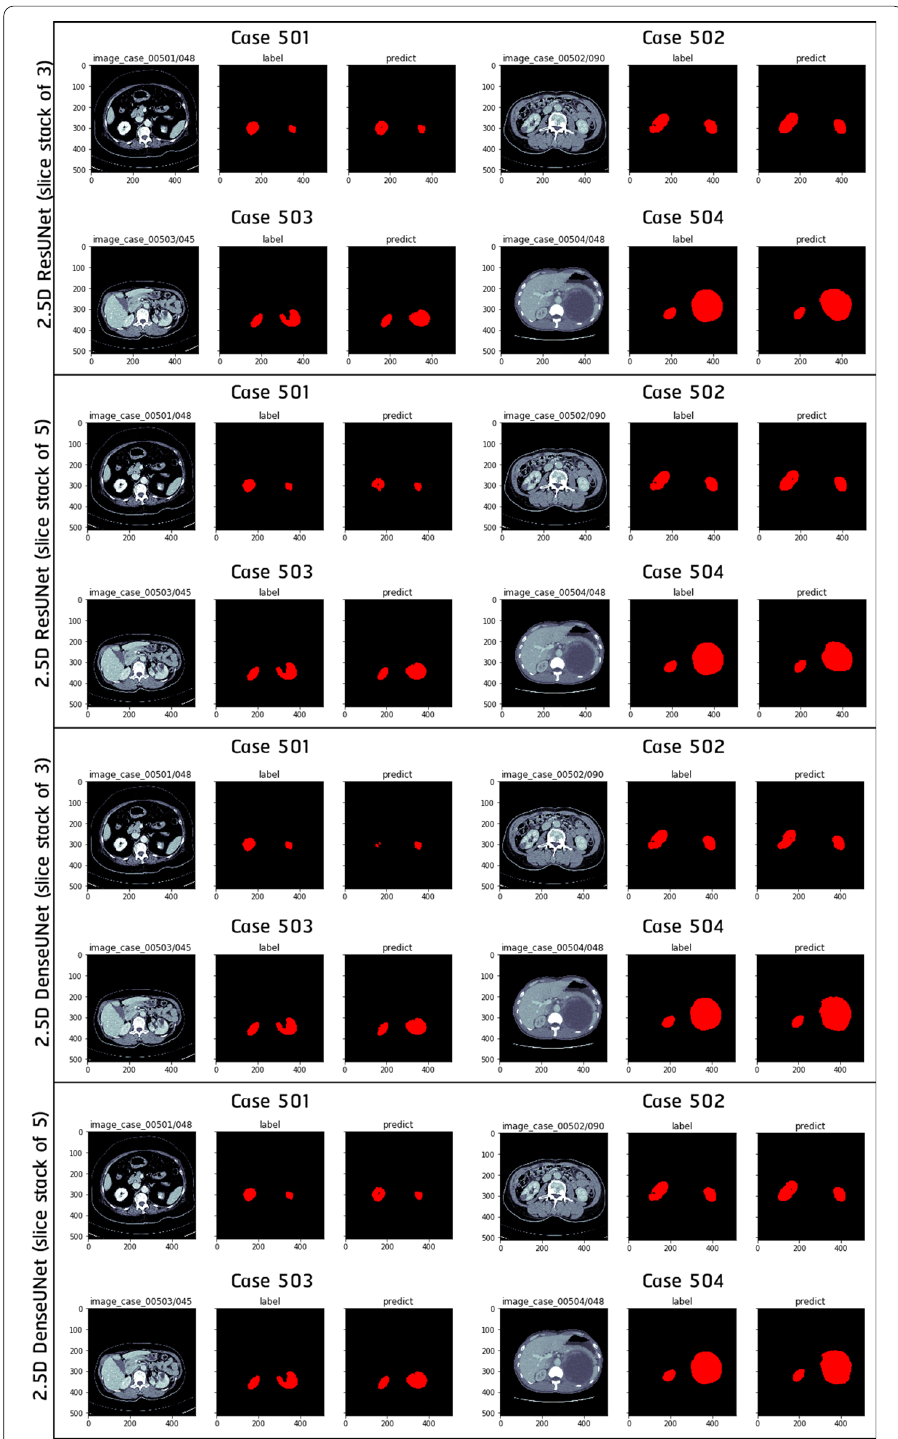
Fig. 4 Kidney segmentation results regarding four Thai patients using models trained in NVIDIA DGX A100 environment. From top to bottom are 2.5D ResUNet (slice stack of 3), 2.5D ResUNet (slice stack of 5), 2.5D DenseUNet (slice stack of 3), and 2.5D DenseUNet (slice stack of